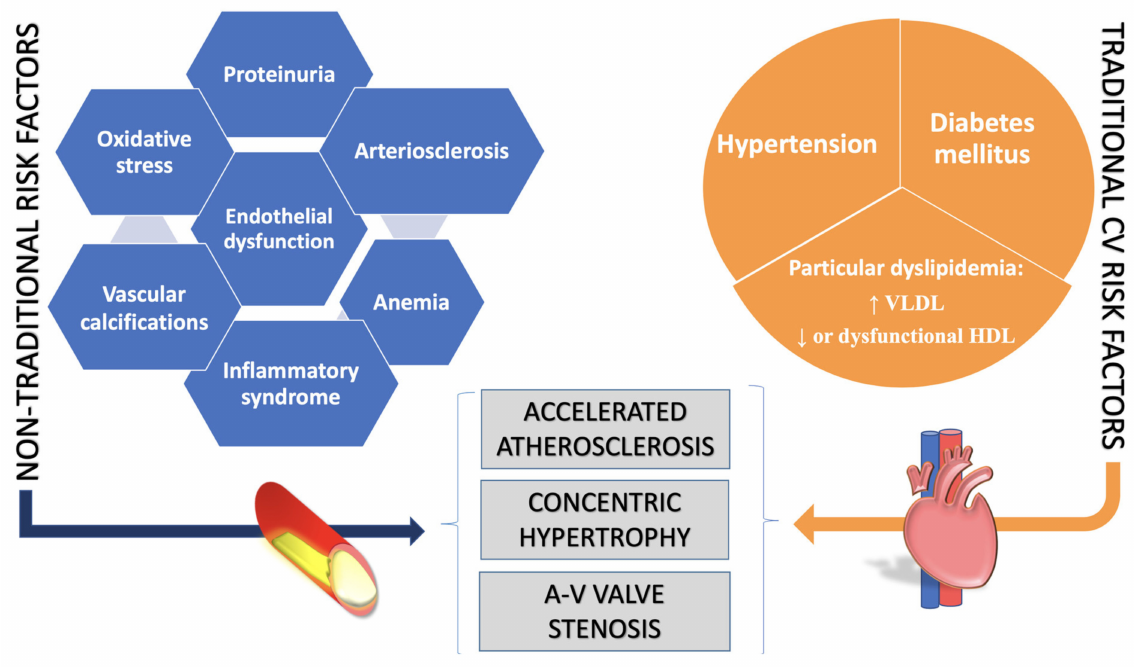
Figure 2. Consequences of the complex interaction between traditional CVRF and non-traditional RF specific to the uremic environment. VLDL—very low-density lipoproteins, HDL—high-density lipoproteins,